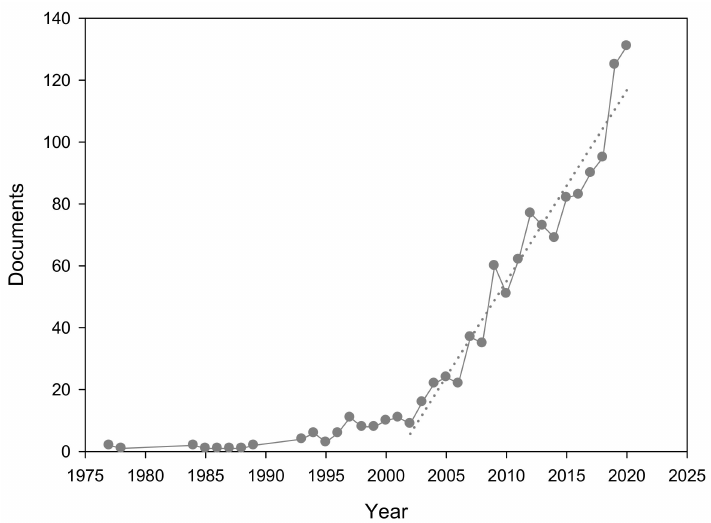
Figure 1. Number of documents in the field of research on solar-driven disinfection from 1977 to